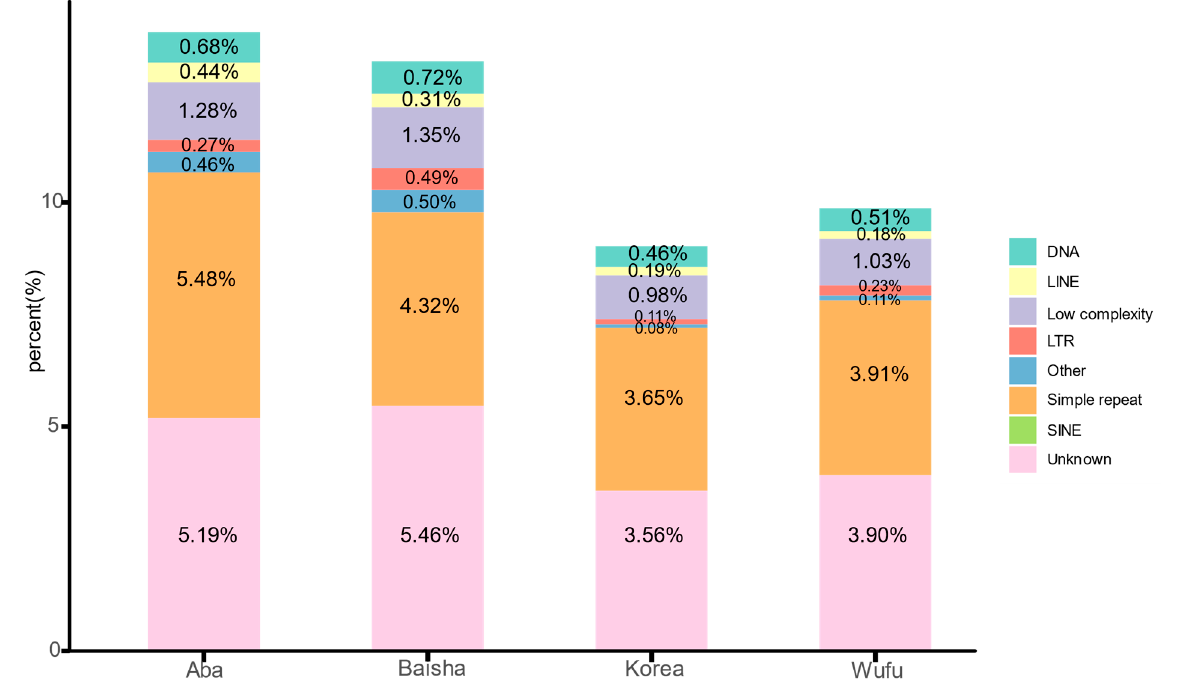
Figure 1. The proportion of different repeat classes in different A. cerana genomes.